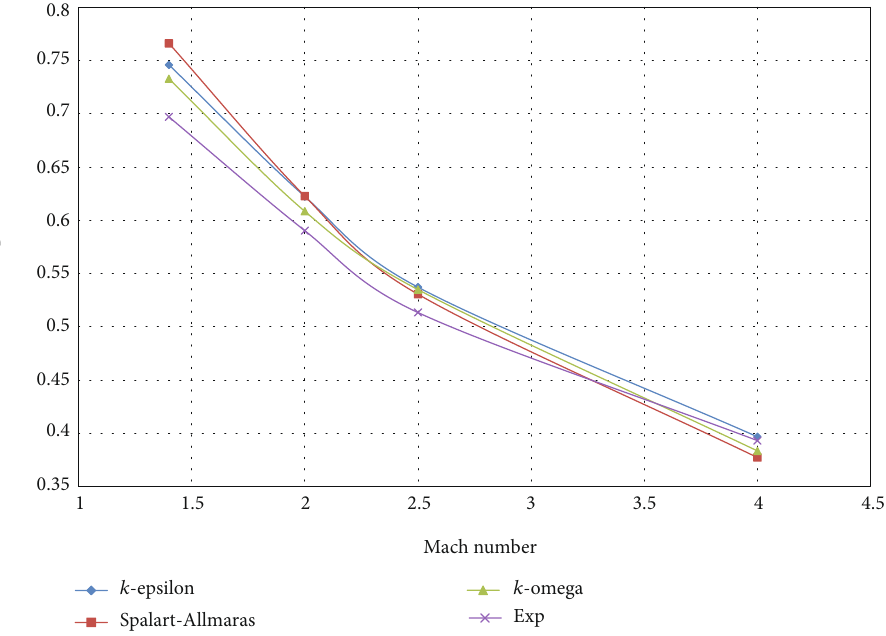
Figure 6: Drag coe ffi cient versus Mach number at 4 ° AoA.